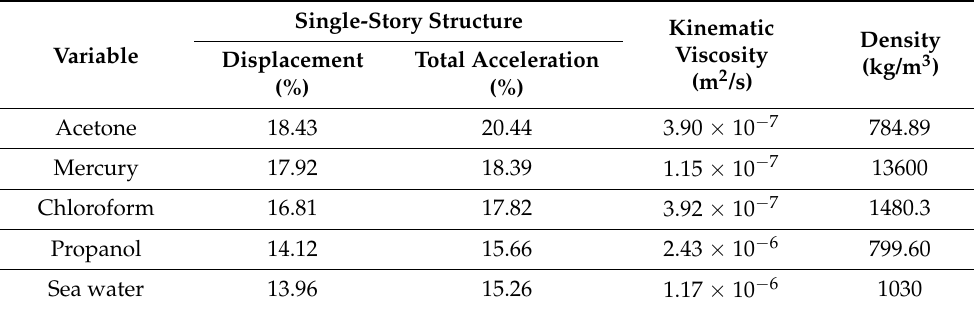
Table 11. Structure displacement and total acceleration reduction percentages with TLD for a single- story structure.